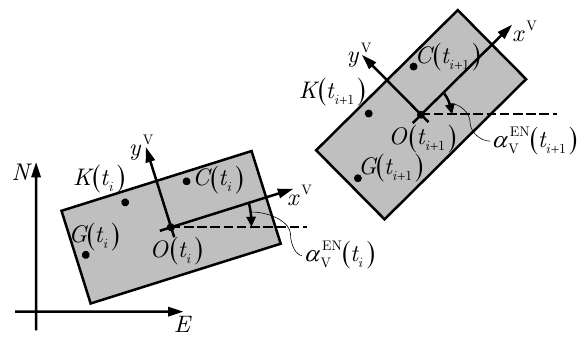
Figure 2. Vehicle at epochs t i and t i +1 . The observation points C , G , K and the vehicle barycentre O are